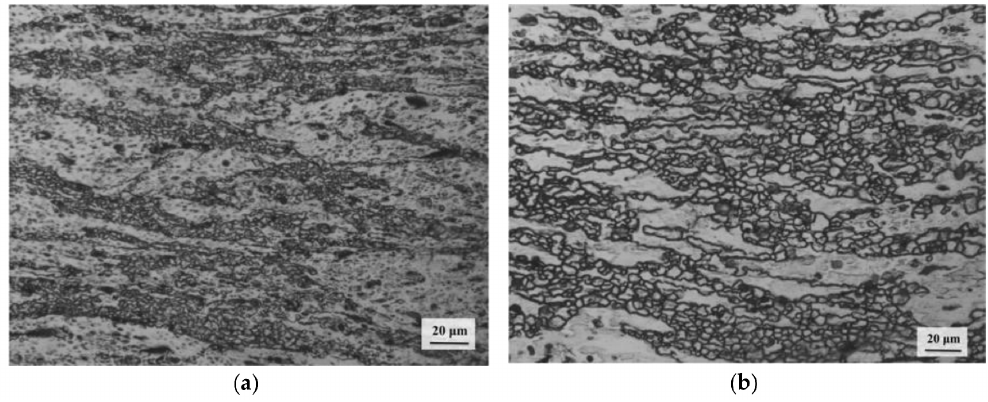
Figure 9. Microstructures of specimens compressed at temperatures and strain rates corresponding to Domain 1 and its close proximity. The compression axis is vertical. ( a ) 300 ◦ C and 0.0003 s − 1 ; ( b ) 350 ◦ C and 0.0003 s − 1 .